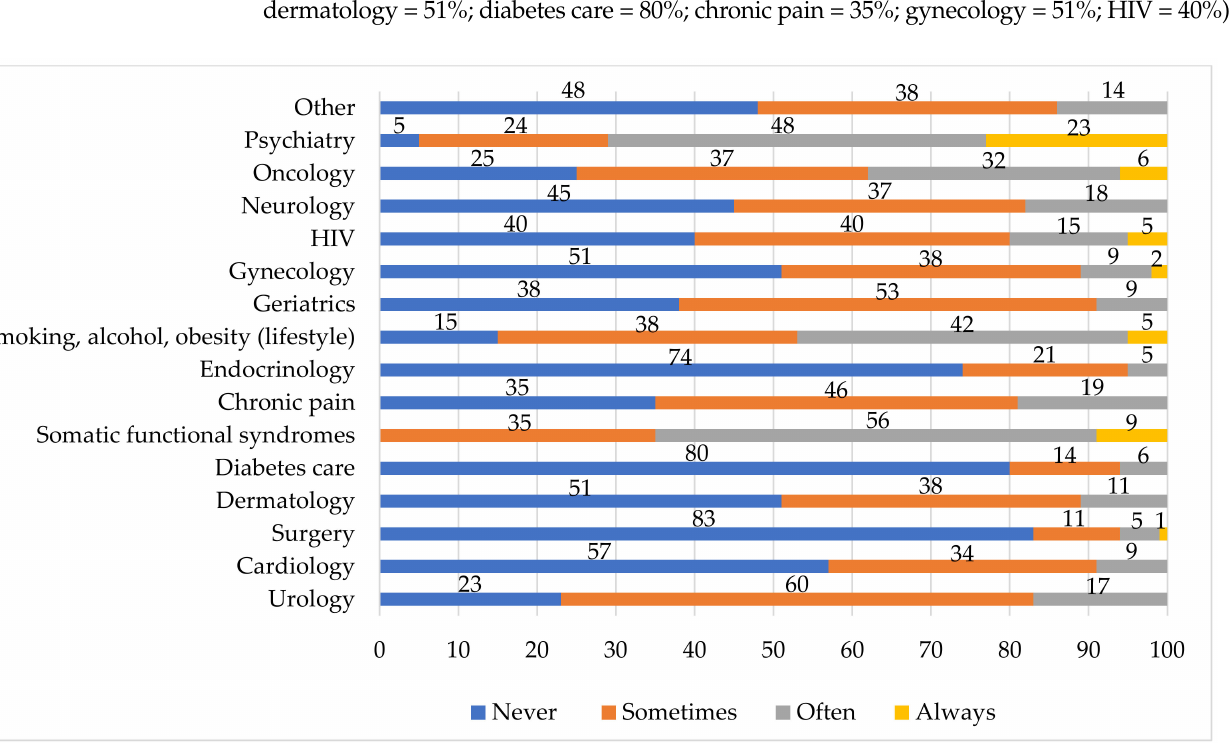
Figure 1. Areas of patients’ symptoms and referral frequency (%) to a